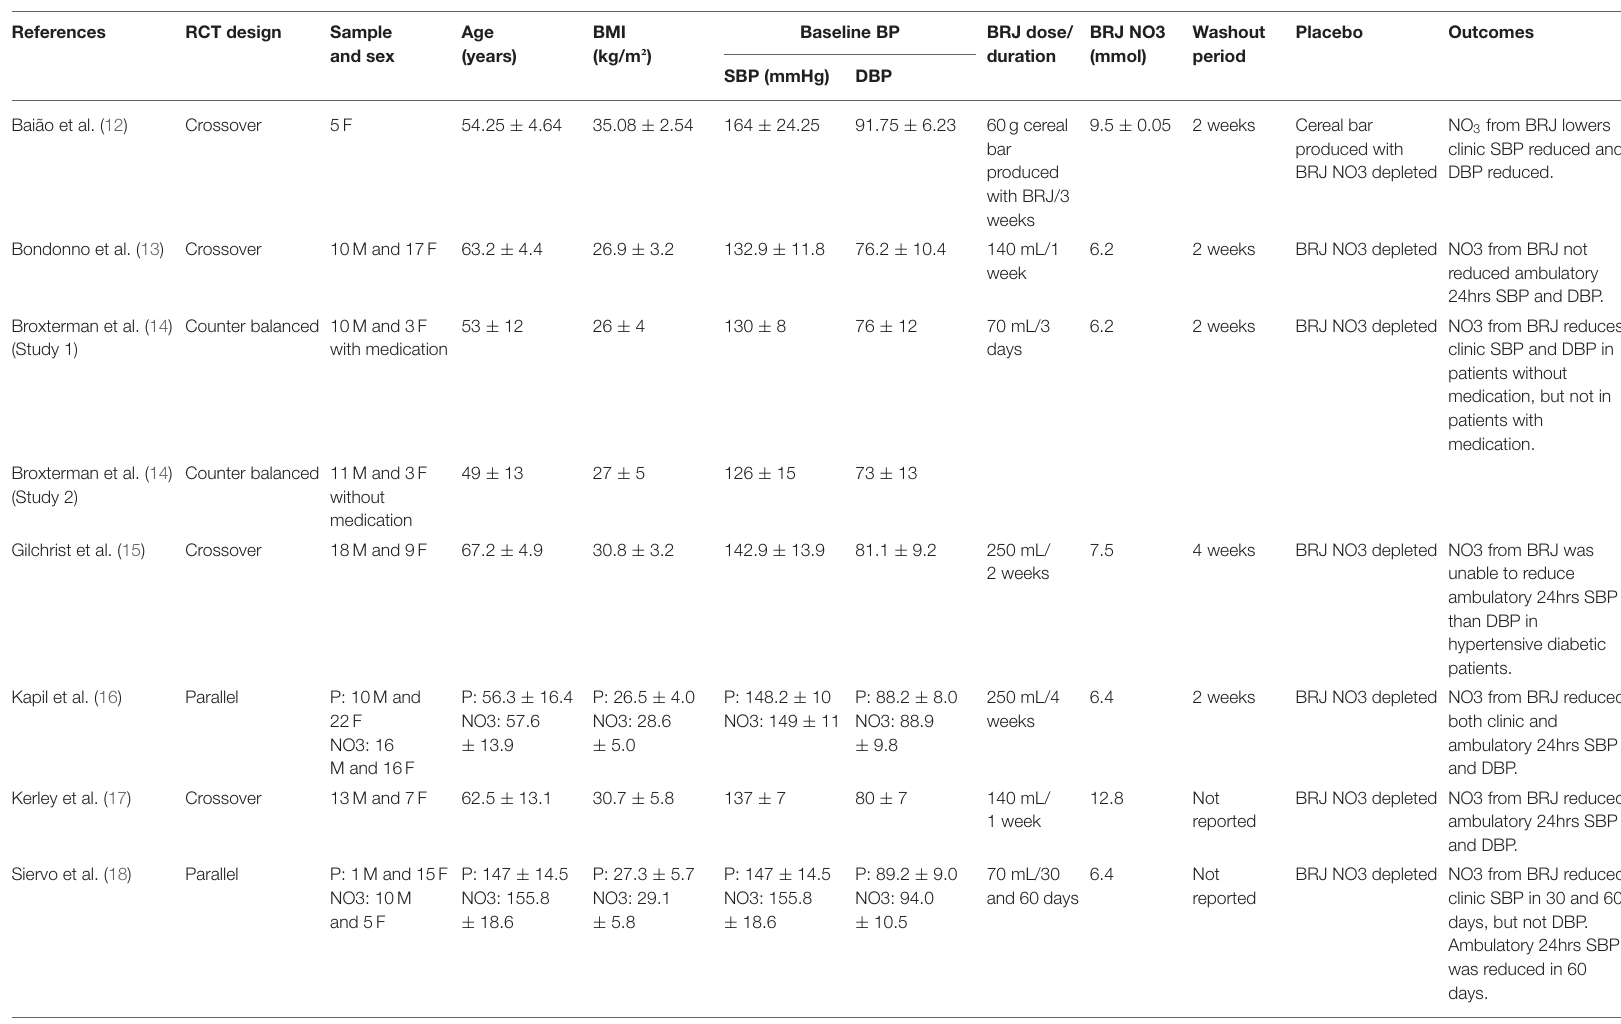
TABLE 1 | Description of the characteristics of the study population, intervention, and outcomes articles by author and year, trial design, sample and sex, age (years), BMI (kg/m ² ), BP baseline, BRJ dose/duration, BRJ NO 3 concentration, washout period, placebo, and